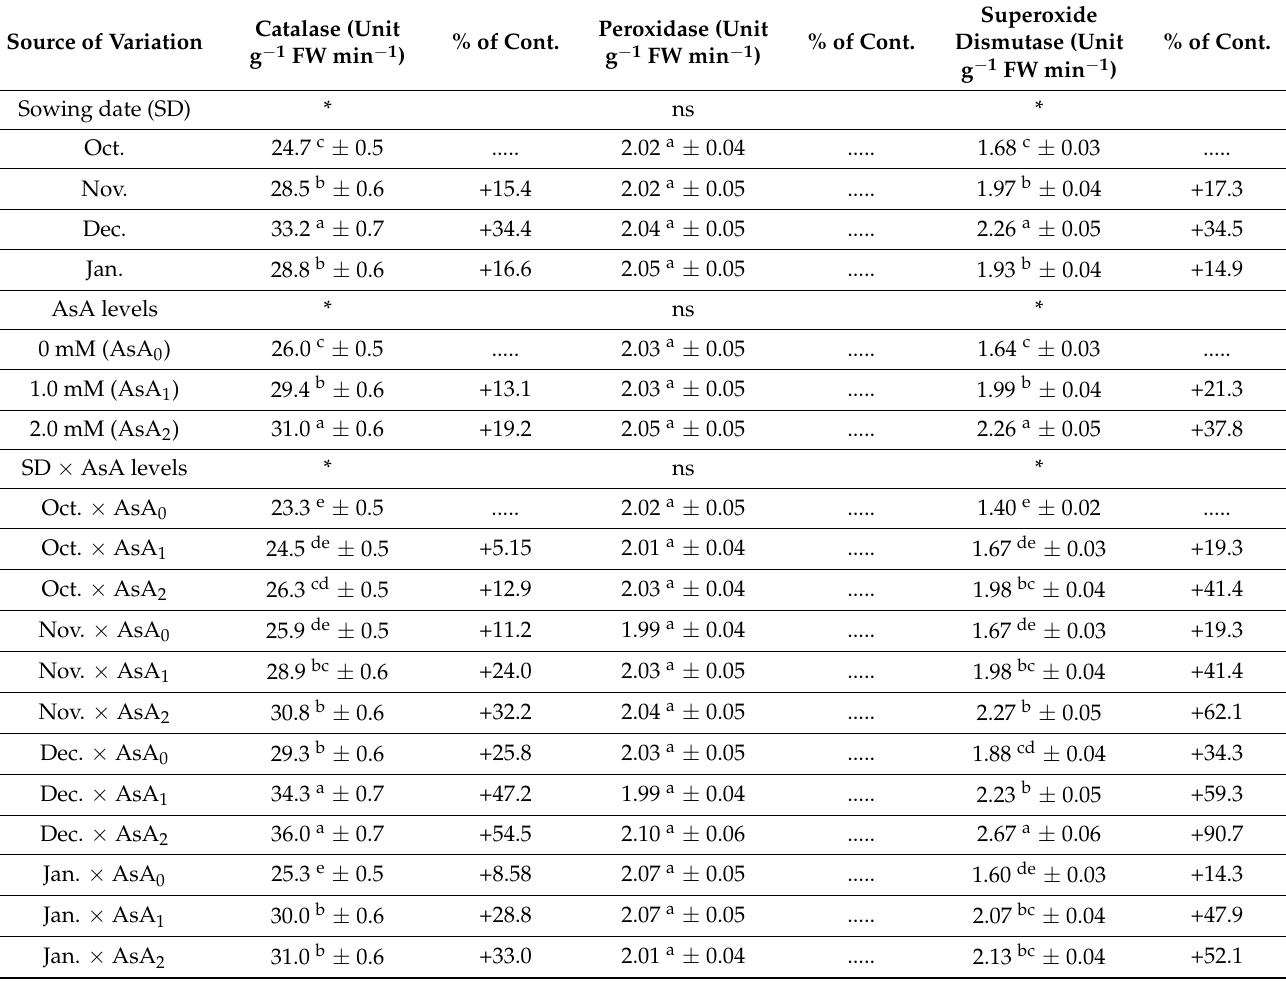
Table 6. Effect of integrative treatment of seeds and leaves with ascorbic acid (AsA) on enzymatic antioxidant activities of parsley plants under different sowing dates vs. October. All values are the average of the 2018/2019 and 2019/2020